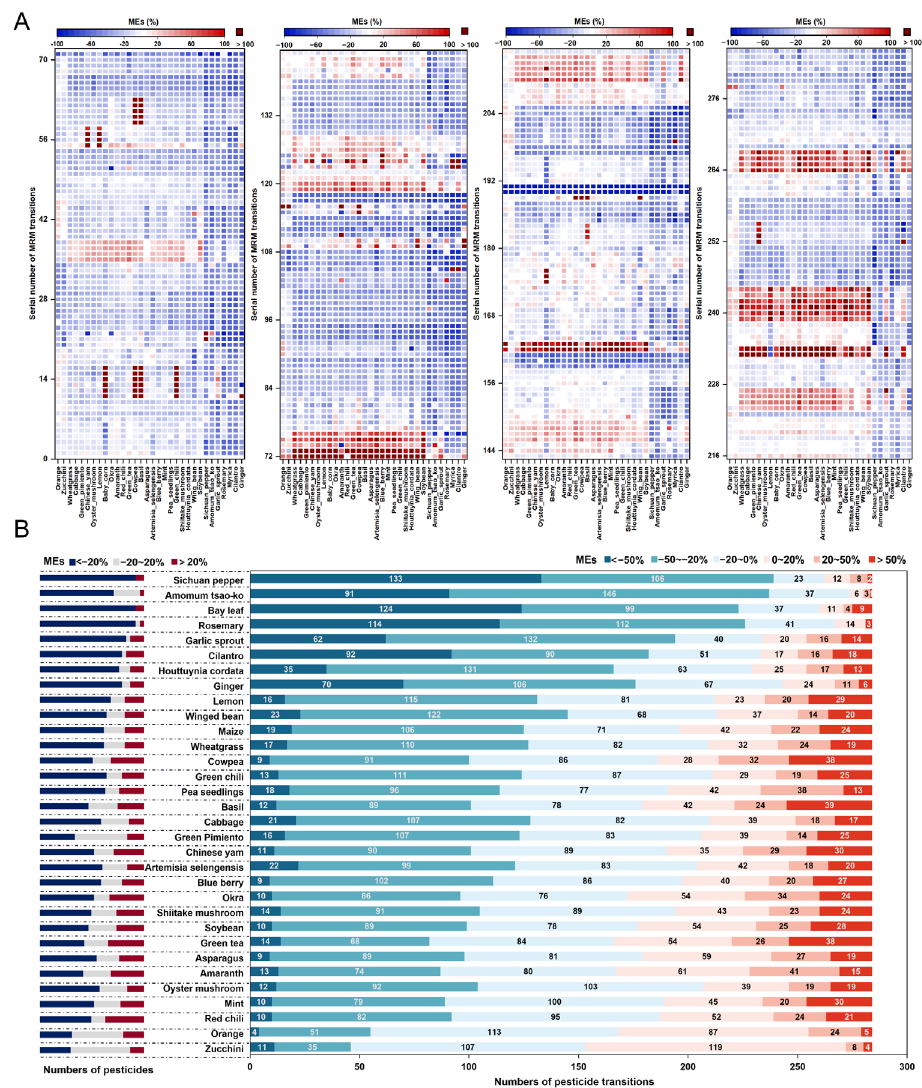
Figure 1. Distribution of matrix effects (MEs) on 284 transitions in 32 matrices ( A ) and the comparison of MEs in different matrix species ( B ) under the MRM scan.